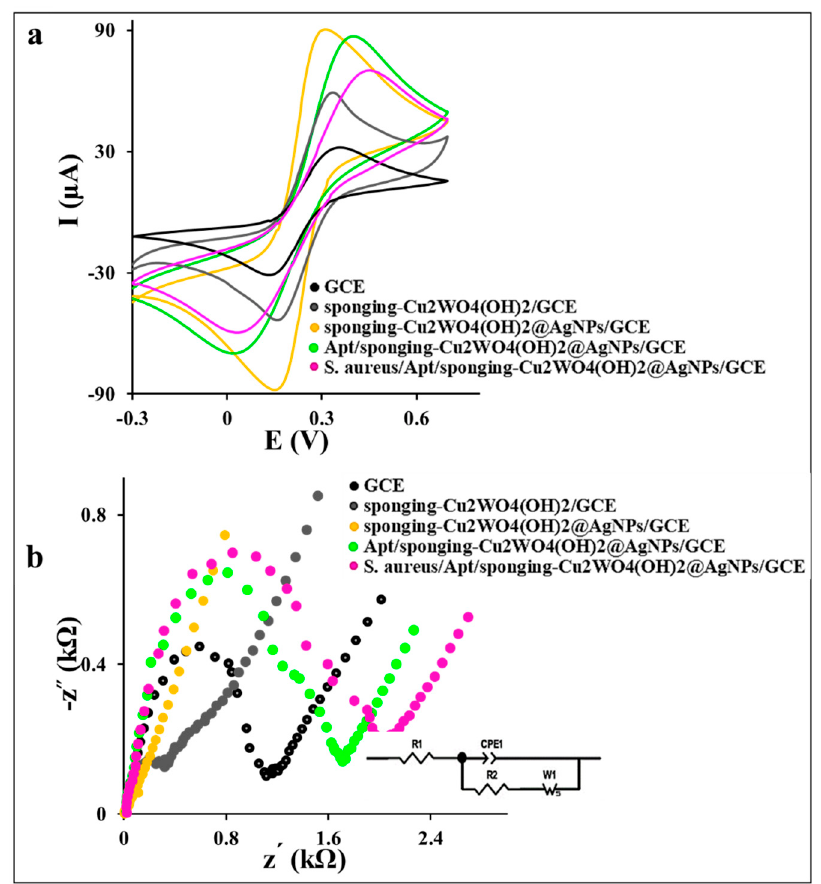
Figure 3. The recorded CVs (at a scan rate of 50 mV s (cid:2879)(cid:2869) ) and Nyquist curves of the GCE, spongin- Cu 2 WO 4 (OH) 2 /GCE, spongin-Cu 2 WO 4 (OH) 2 @AgNPs/GCE, Apt/spongin- Cu 2 WO 4 (OH) 2 @AgNPs/GCE, and 10 8 CFU mL − 1 S. aureus incubated on the Apt/spongin- Cu 2 WO 4 (OH) 2 @AgNPs/GCE in 0.1 M PBS containing 0.1 M KCl and 1 mM [Fe(CN) 6 ] 3 − /4 − as the redox marker.